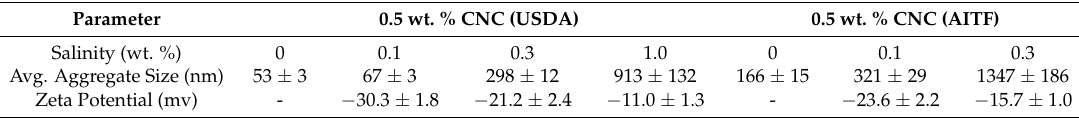
Table 4. Aggregate sizing data (measured by DLS) and zeta potential data for the solutions used in the floods. The zero salinity value corresponds to the nominal particle size. Parameter 0.5 wt. % CNC (USDA) 0.5 wt. % CNC (AITF) Salinity (wt. %)